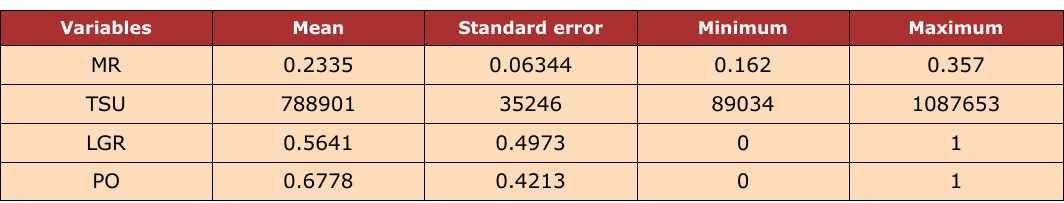
Table 2. descriptive statistics of the variables